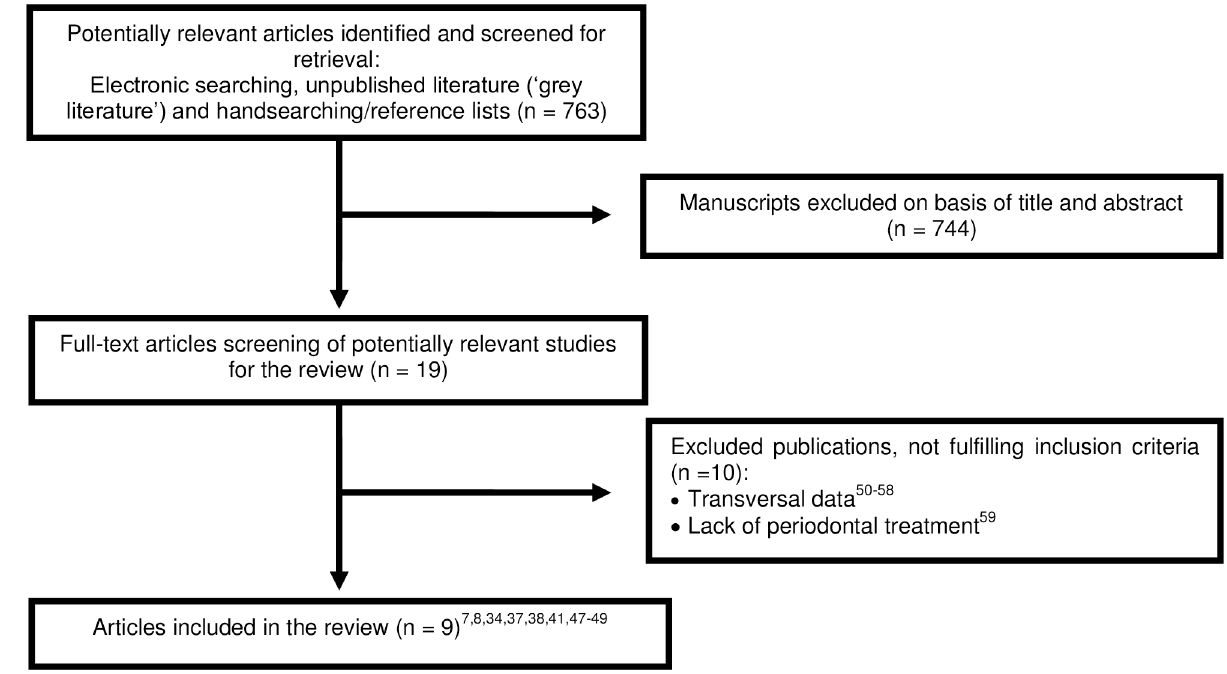
Fig 2. Flowchart of manuscripts screened trough the review